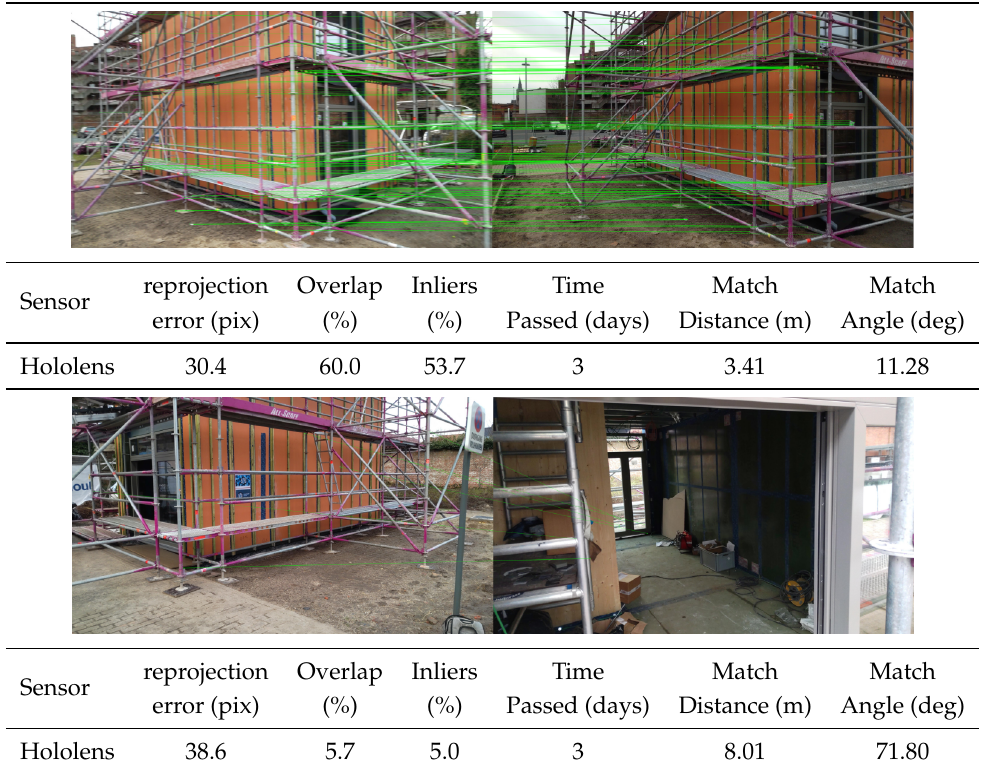
Table 3. Examples of a correct and incorrect image